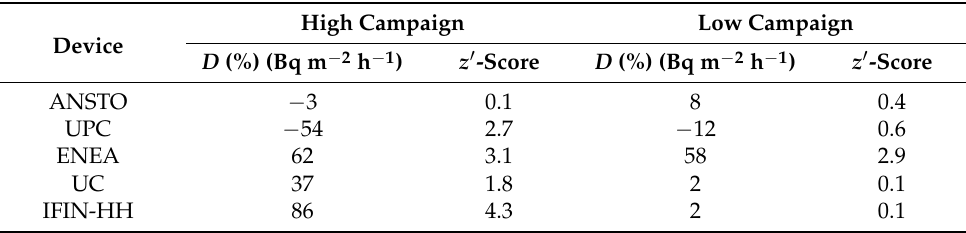
Table 10. Relative difference percentage D (%) and z (cid:48) -score calculated from participant results and the consensus